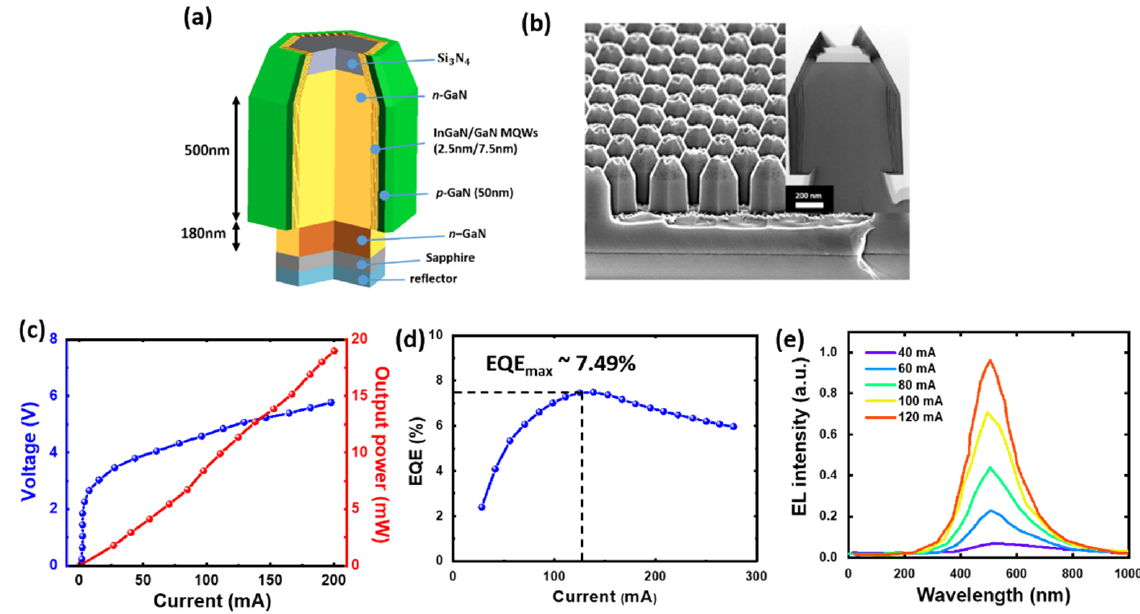
Figure 2. ( a ) Schematic diagram of tip-free nanorod LED; ( b ) top-view SEM and TEM image of tip-free nanorod LED; ( c ) L-IV characteristics; ( d ) EQE value as a function of injection current; ( e ) EL spectrum versus different driving currents.